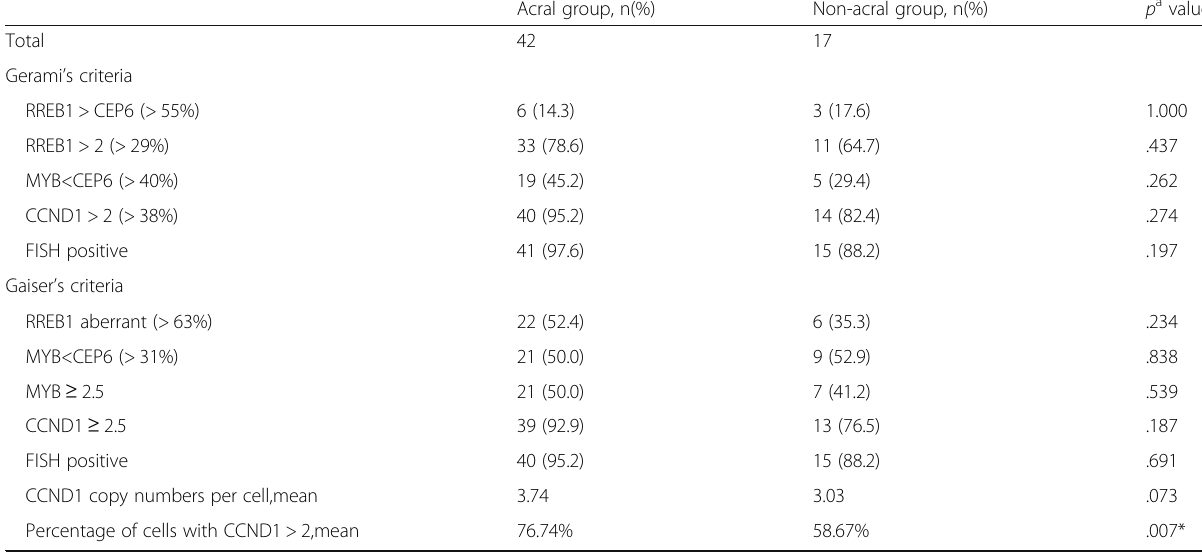
Table 4 Comparison of the number and percentage of cases meeting each criterion of Gerami and Gaiser, and CCND1 amplification between the acral and non-acral groups of